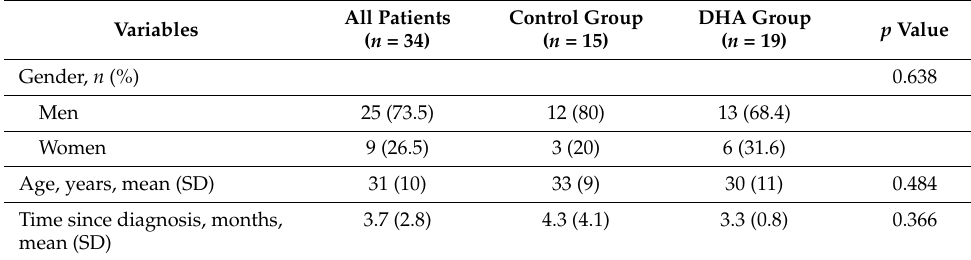
Table 1. Baseline demographic and clinical data of 34 patients with